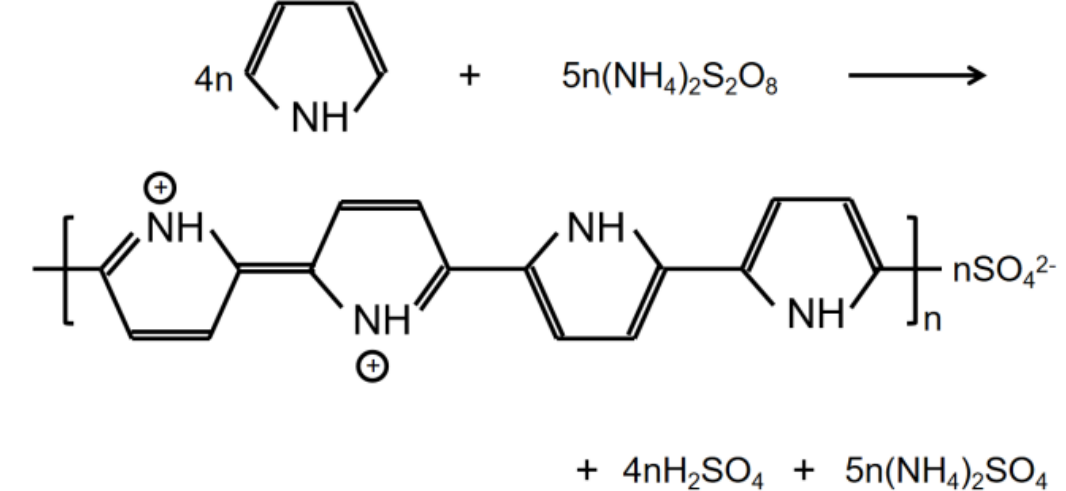
Figure 1. The possible reaction mechanism of Py and APS.